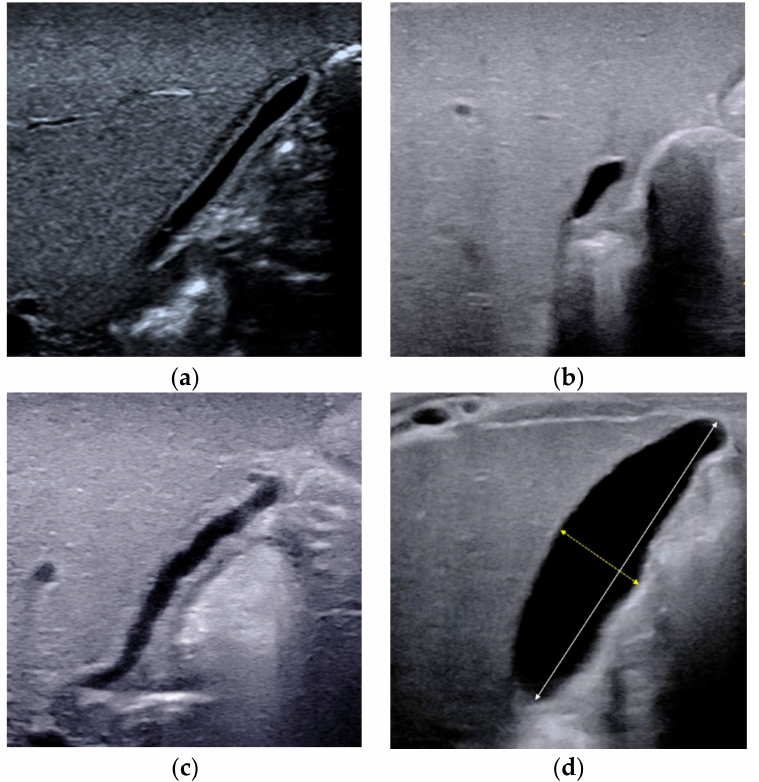
Figure 1. Different types of gallbladders detected by conventional ultrasound. ( a ) Type II gallbladder in non-BA. ( b ) Type III gallbladder in BA. ( c ) Type IV gallbladder with length-to-width ratios of >5.2 in BA. ( d ) Type IV gallbladder with length-to-width ratios of ≤ 5.2 in non-BA. The maximum lumen length and width should be measured from inner wall to inner